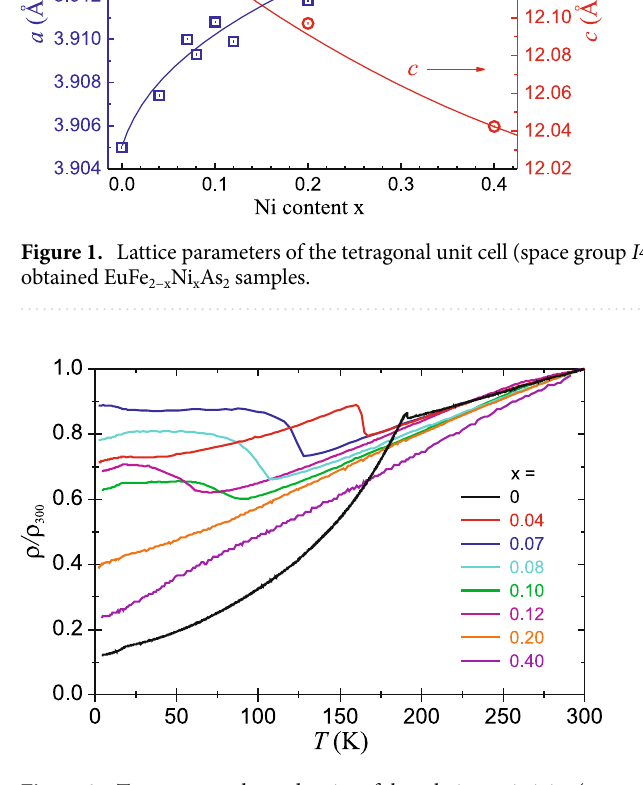
Figure 2. Temperature dependencies of the relative resistivity (normalized to the resistivity at 300 K) for EuFe 2−x Ni x As 2 samples. The current was applied perpendicular to the c -axis. The resistivity anomaly associated with the iron magnetism is clearly visible for all studied samples, except the highest Ni-substitution levels x = 0.20 and